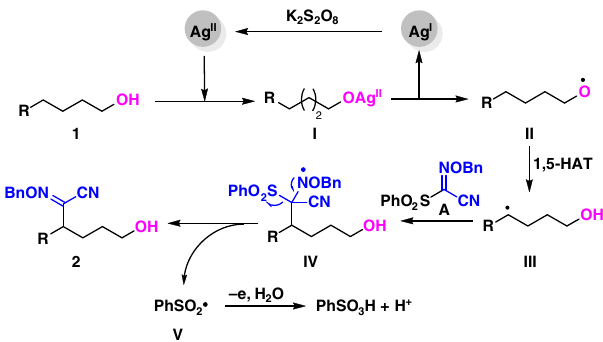
Fig. 2 The chemoselective transformation of 2 . The oxime ether product 2